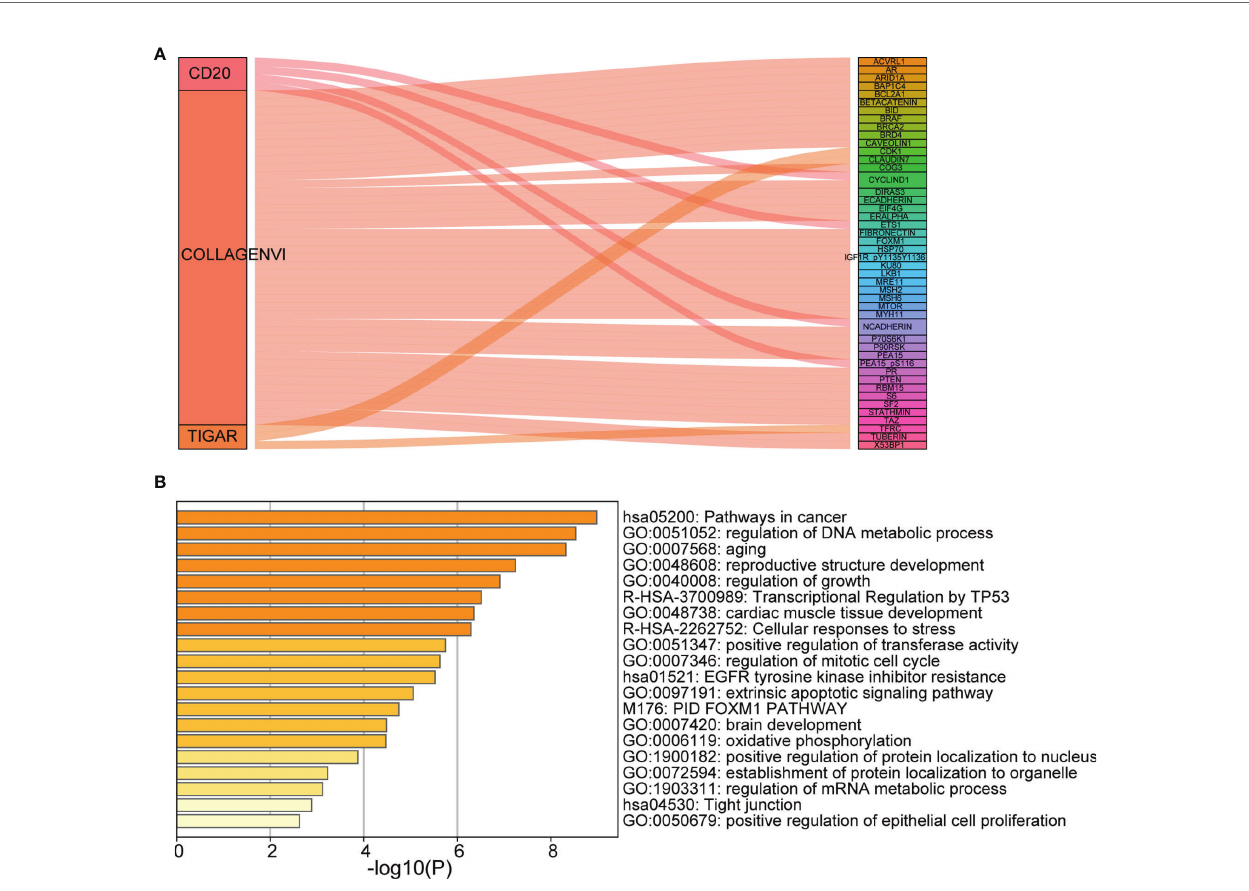
FIGURE 7 | Analysis of co-expressed proteins and functions. (A) Sankey diagram; (B) The main enrichment pathways (GO and KEGG analyses). Each rectangle denotes a gene, with the connection degree visualized by the rectangle area. The circle area re fl ects the number of genes on the pathway, while the color depth shows the -log10 (FDR) value. GO, Gene Ontology; KEGG, Kyoto Encyclopedia of Genes and